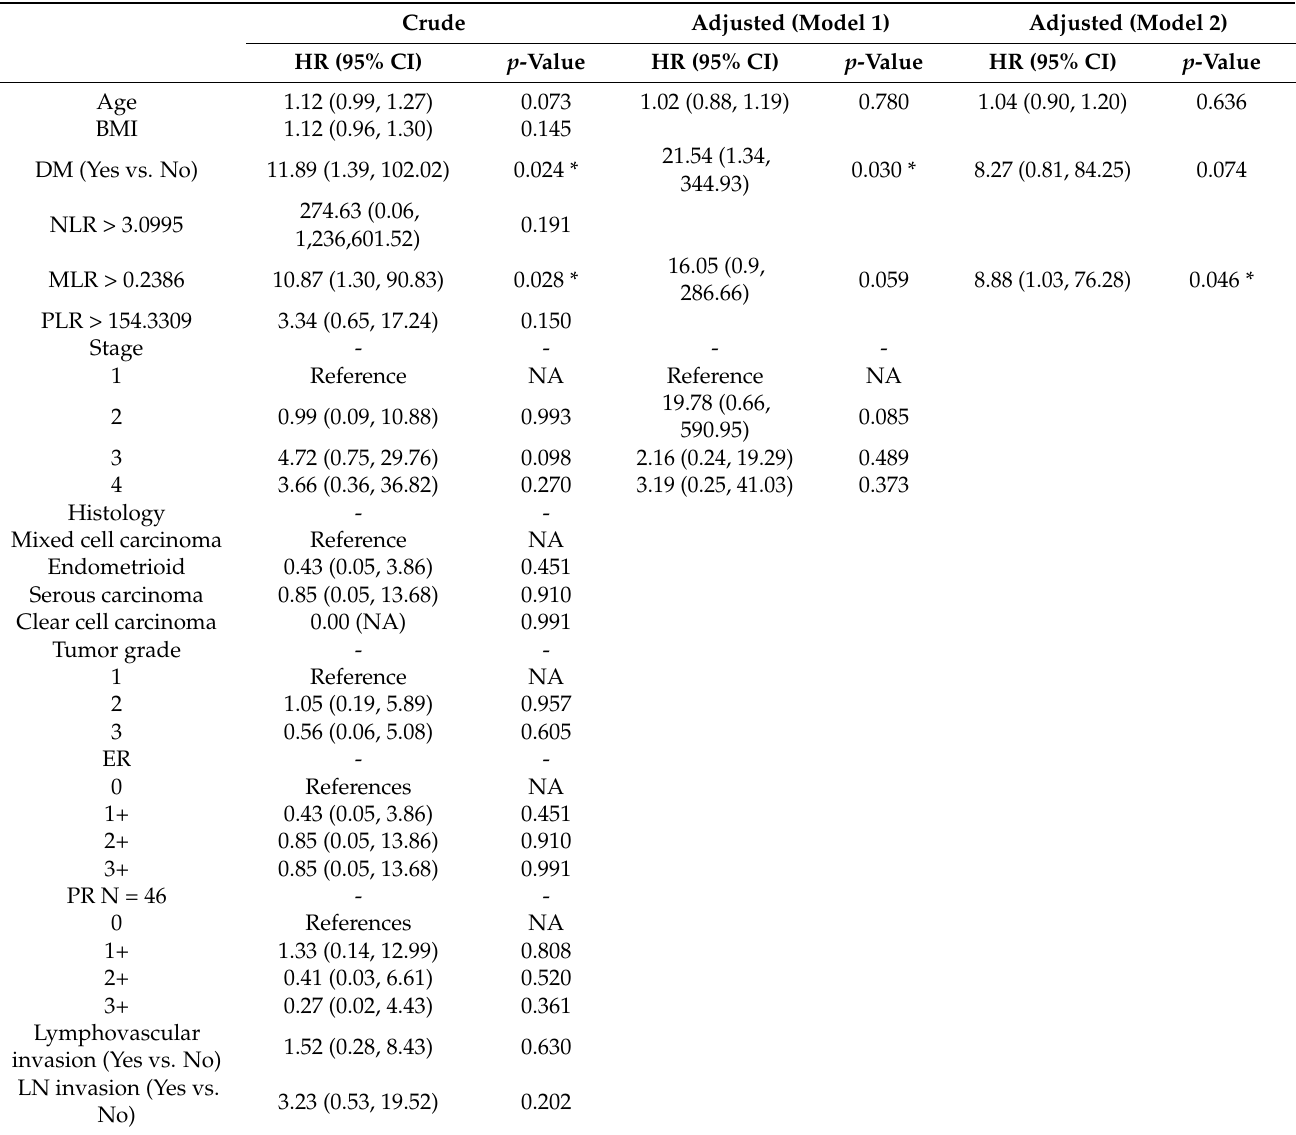
Table 2. Factors associated with mortality ( n = 48).